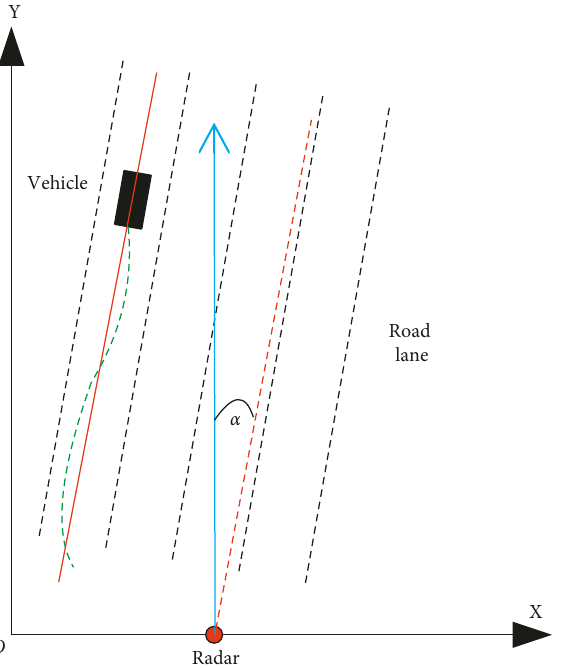
Figure 4: The schematic diagram of lane